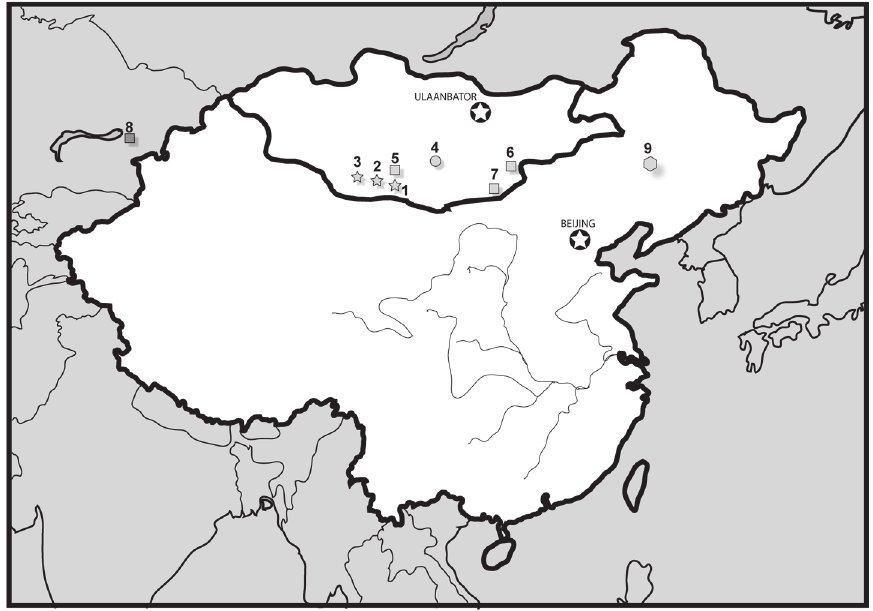
Fig 1. Geographic map showing the distribution of Asian paralligatorid species across China, Mongolia, and Uzbekistan. Stars = Nemegt Formation (Fm.) taxa; circles = Djadokhta Fm. taxa; squares = Bayanshiree Fm. (or equivalent) taxa; polygon = Lower Cretaceous. 1. Shamosuchus ancestralis ; 2. S. ulanicus ; 3. S. tersus ; 4. S. djadochtaensis ; 5. S. gradilifrons ; 6. S. major ; 7. S. ulgicus ; 8. S. borealis ; 9. Rugosuchus nonganensis